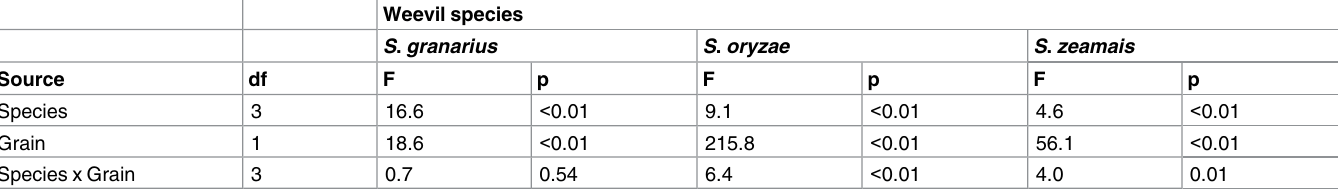
Table 1. ANOVA parameters for comparison of adult numbers in vials at end of the test among species and grain type (rice or maize).